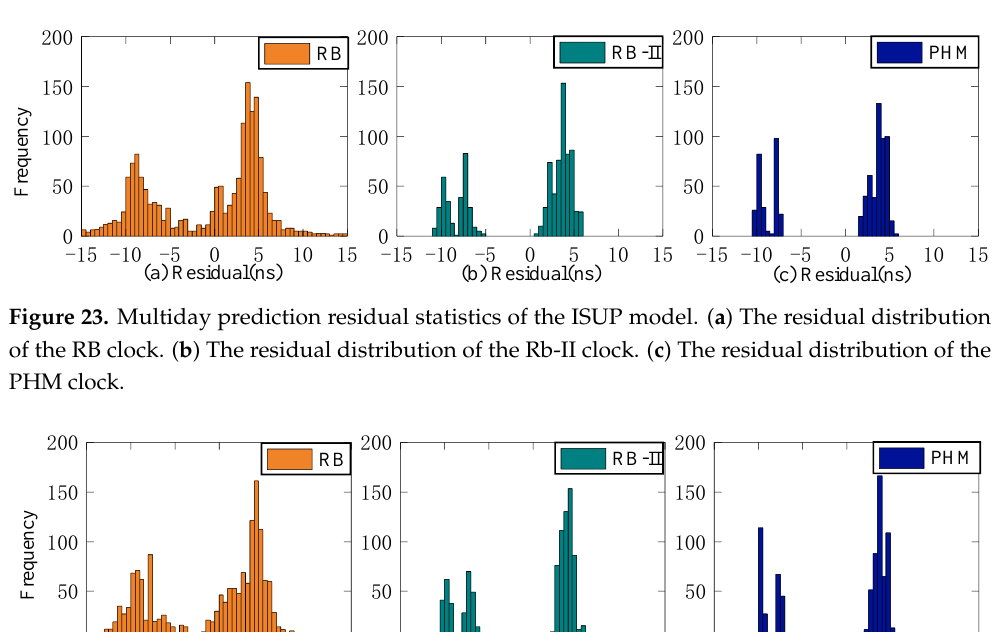
Figure 25. Multiday prediction residual statistics of the GM model. ( a ) The residual distribution of the RB clock. ( b ) The residual distribution of the Rb-II clock. ( c ) The residual distribution of the PHM clock.